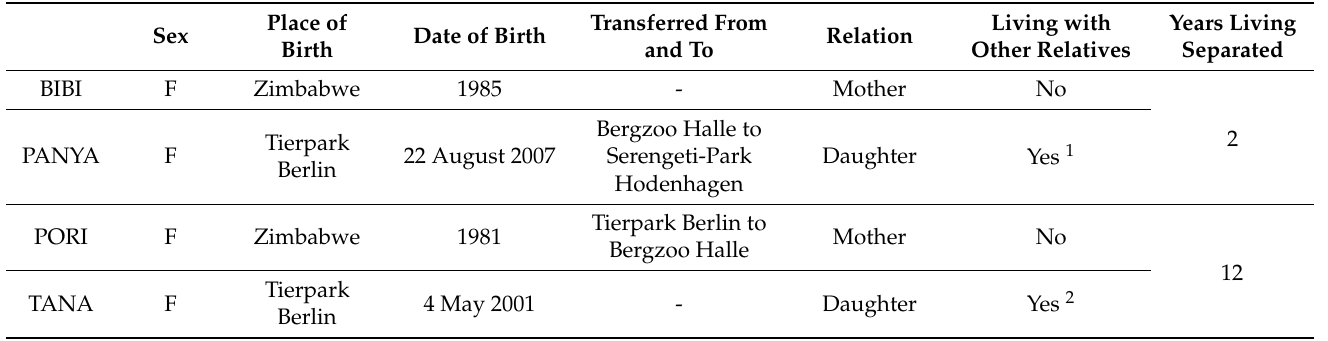
Table 1. Record of elephants of the